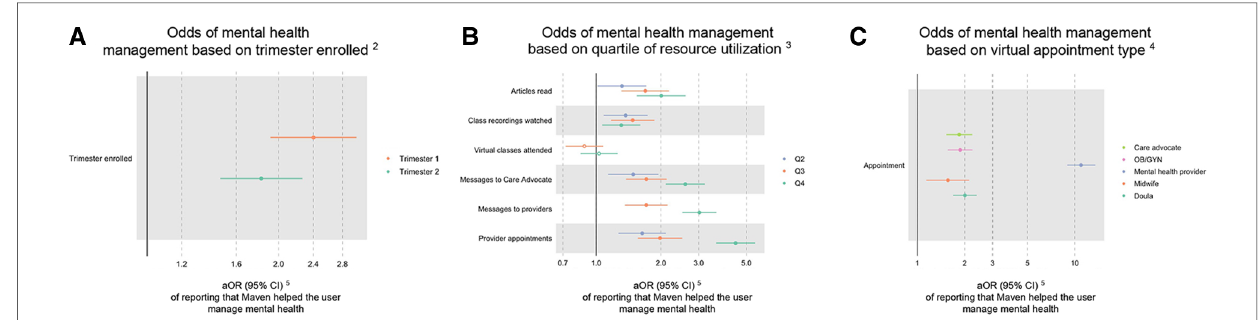
FIGURE 3 Effect of utilization on mental health management in total sample 1 . ( A ) Odds of mental health management based on trimester enrolled 2 . ( B ) Odds of mental health management based on quartile of resource utilization 3 . ( C ) Odds of mental health management based on virtual appointment type 4 . 1 Filled data points represent statistically signi fi cant fi ndings ( p <0.05), and un fi lled data points represent fi ndings that are not statistically signi fi cant. 2 Compared to Trimester 3 enrollment. 3 Compared to Quartile 1 utilization. 4 Compared to users who did not have an appointment with each provider type. 5 Adjusted odds ratio (95% con fi dence